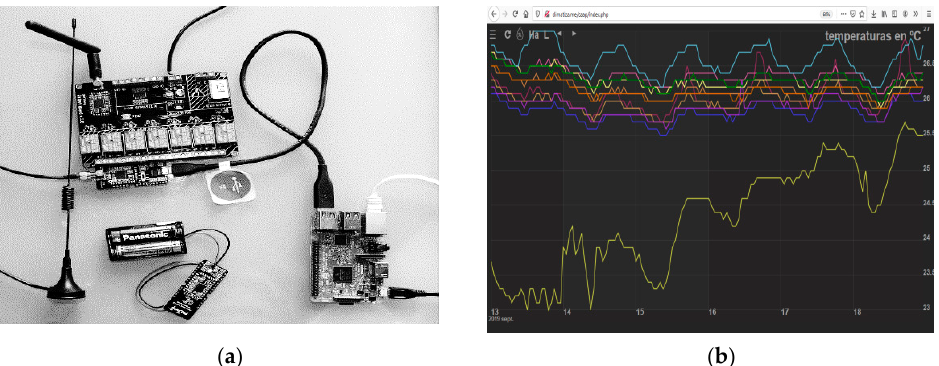
Figure 3. Environmental monitoring and control system (EMS). ( a ) Raspberry Pi mini-pc, panStamp communication module with radio communication antenna, and one of the independent modules with a TH sensor connected to its batteries. ( b ) Domolibre interface for data visualisation and for the control of the monitoring system through remote connection by means of a web client.